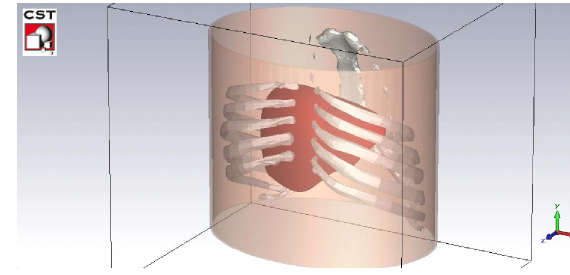
Figure 8: Abdomen model used in